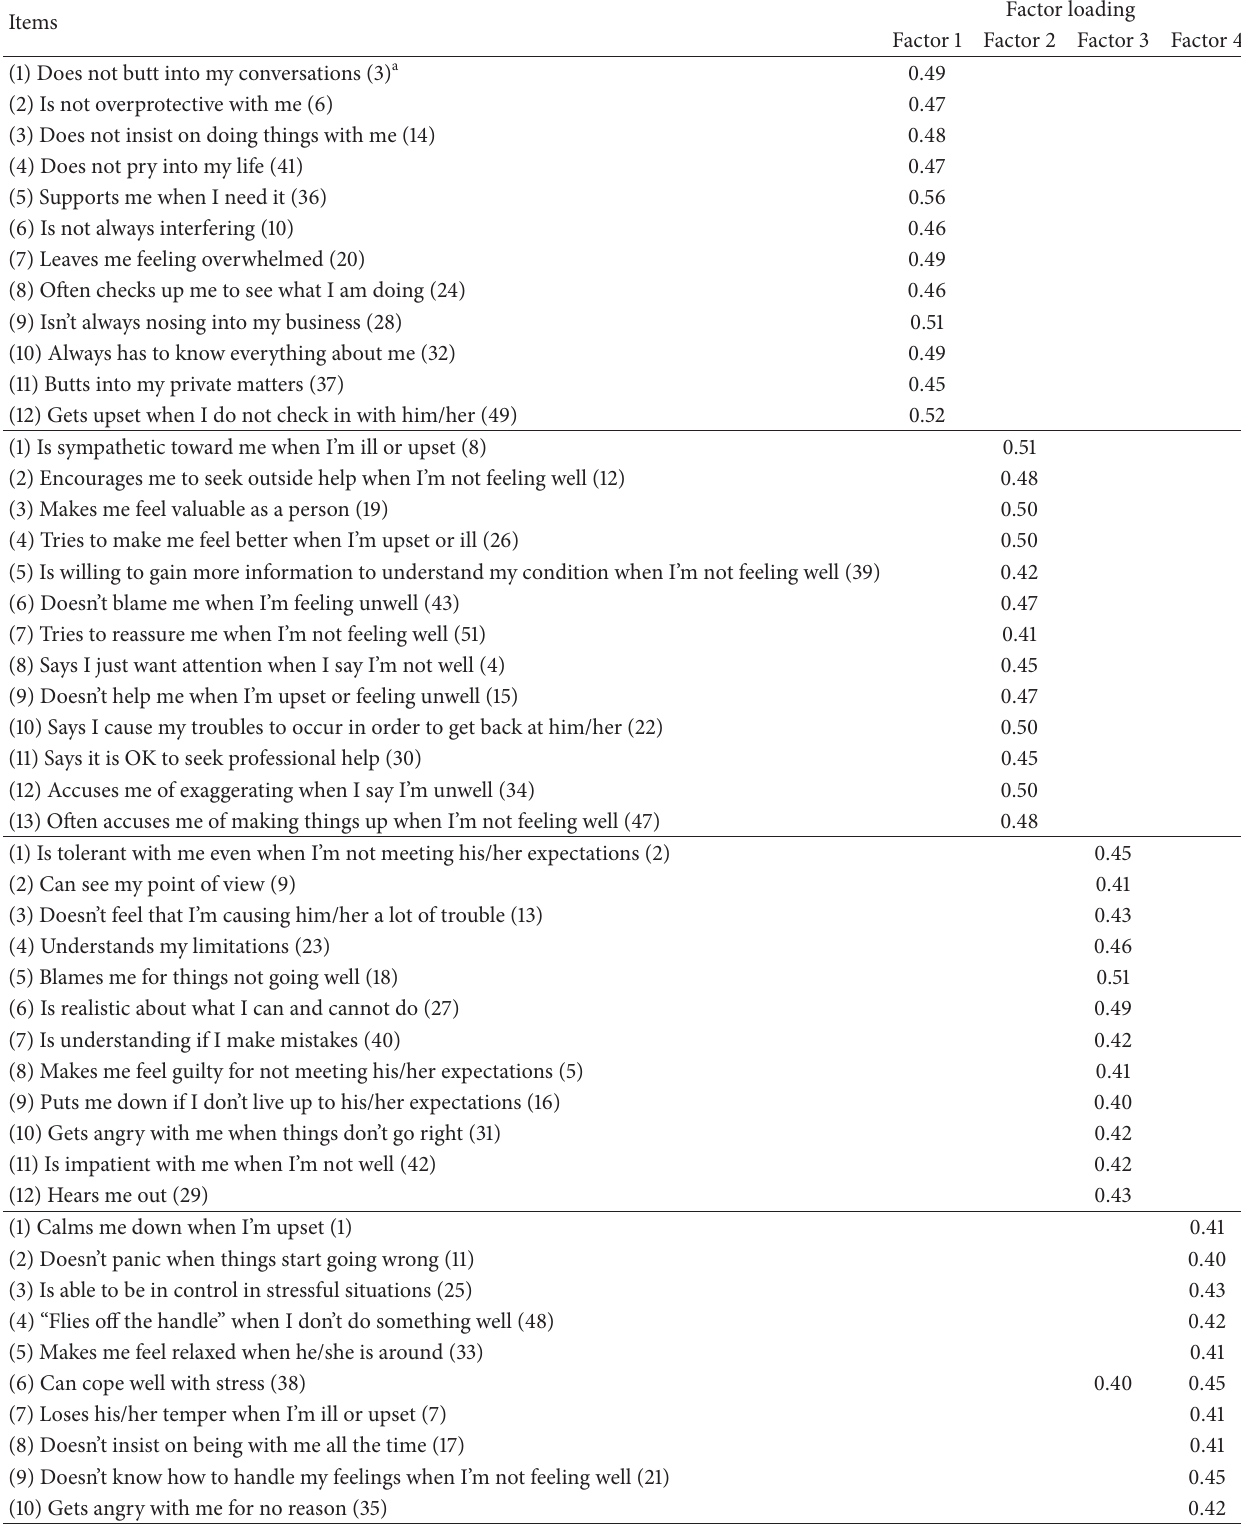
Table 3: Results of varimax rotation of four factors identified from the Chinese